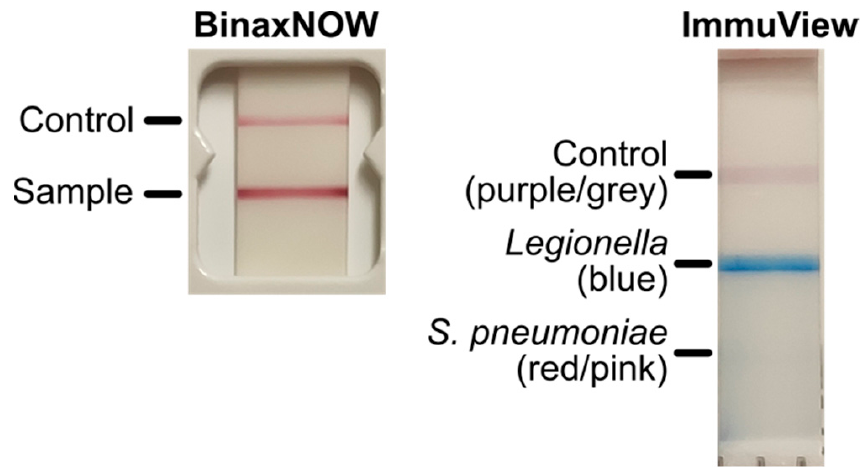
Figure 2. BinaxNOW and ImmuView test results for positive case P4.